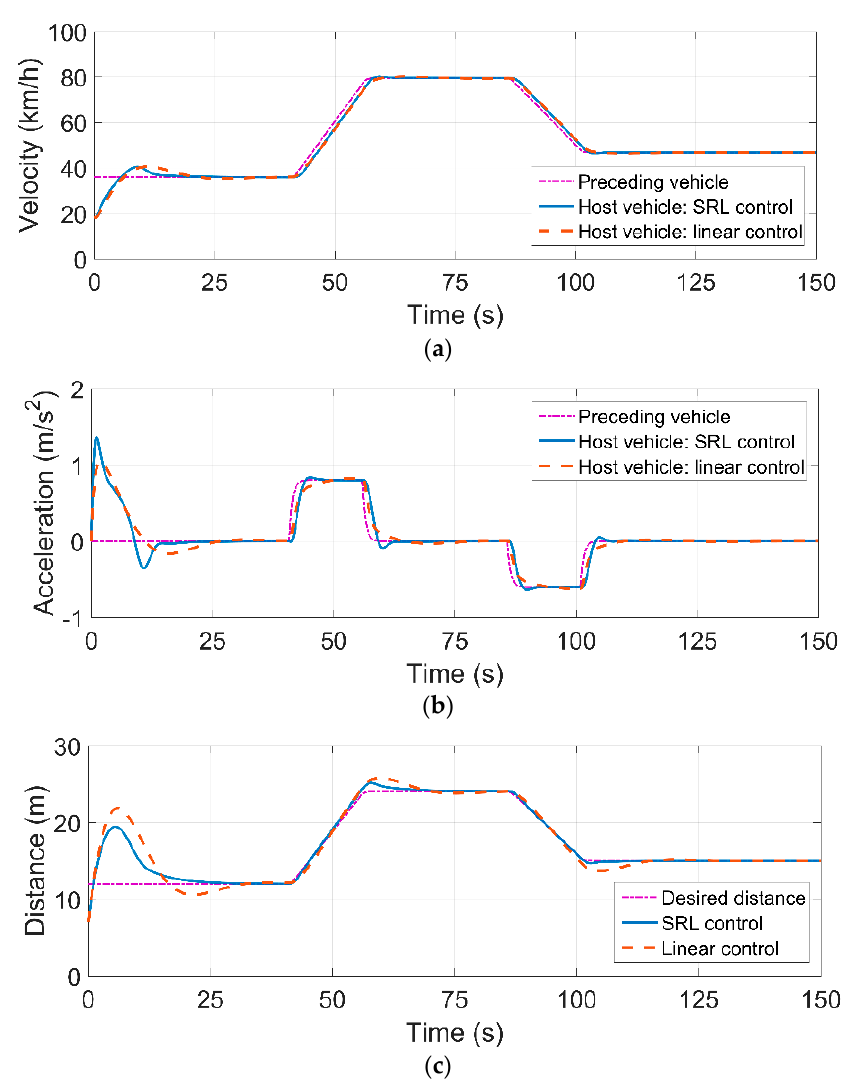
Figure 5. Simulation results with the cycle of step acceleration and deceleration: ( a ) velocity, ( b ) acceleration, and ( c ) distance. Table 2. Maximum, average, and variance of distance error, with the cycle of step acceleration and deceleration.